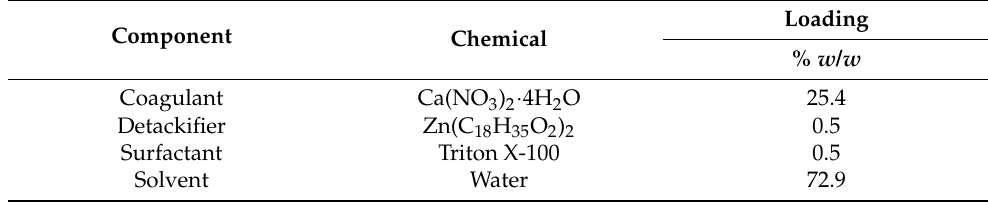
Table 2. Recipe for GNRL